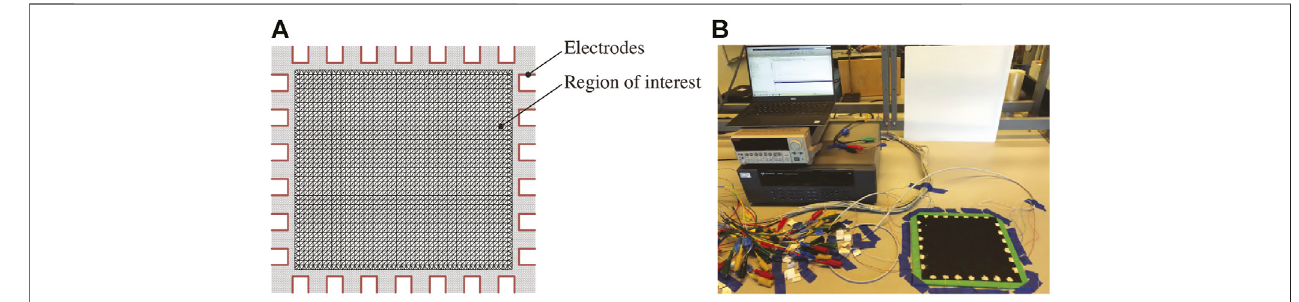
FIGURE 3 | (A) FE model of the specimen and (B) experimental